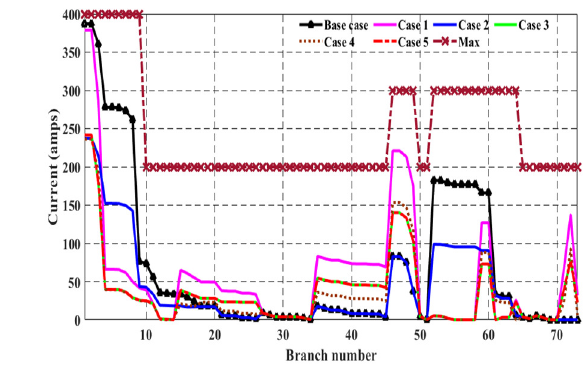
Fig. 11: Current Distribution in Branches of IEEE 69-Bus System